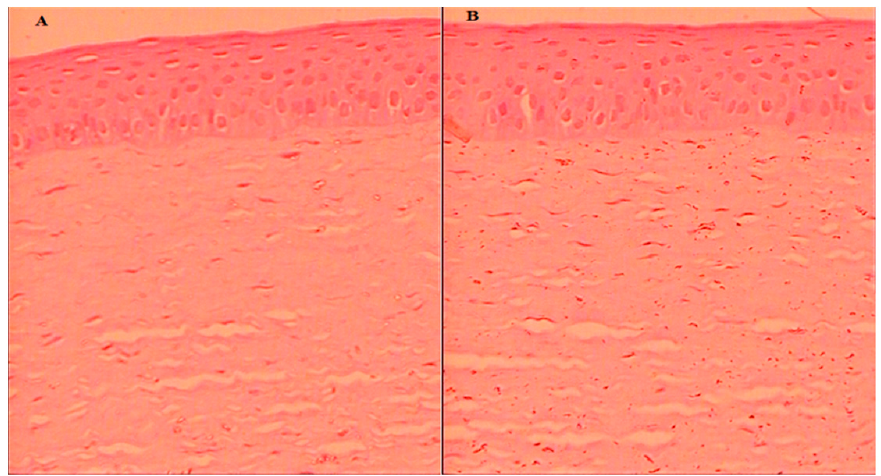
Figure 7. Histopathology image of AM-NLopIG-treated cornea ( A ). NaCl-treated cornea ( B ) taken by light microscope at image scale 40×.